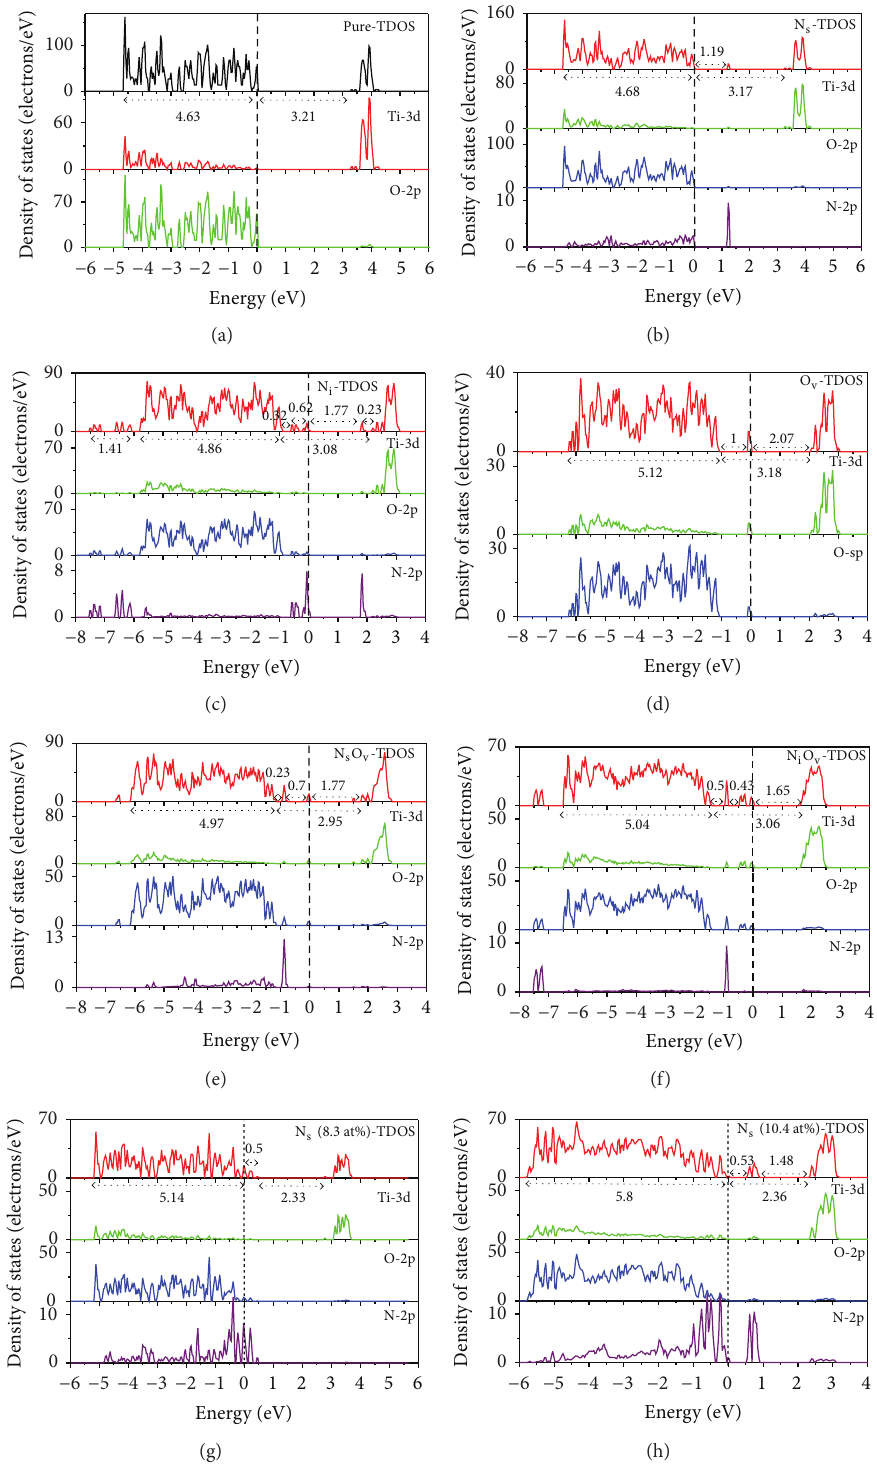
Figure 4: DOS of various defective models of N-doped TiO 2 : (a) pure TiO 2 , (b) N s (2.1 at.%), (c) N i , (d) O v , (e) N at.%), and (h) N s (10.4